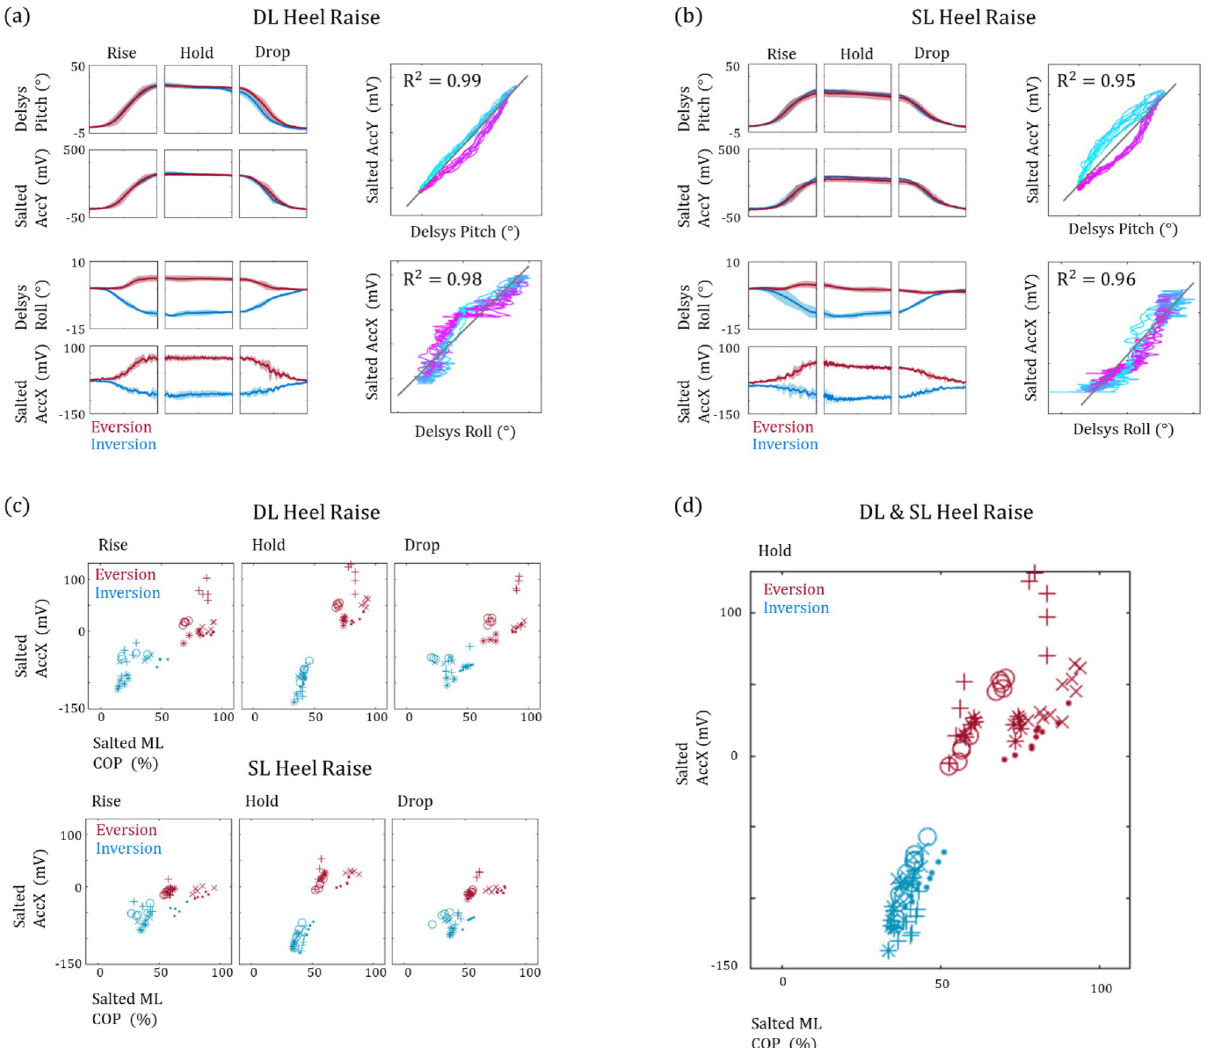
Figure 4. Analysis of acceleration data obtained from Salted smart insoles during heel raise. A representative plot of foot pitch and roll obtained from Delsys Trigno sensors and acceleration data from the smart insoles during ( a ) double leg and ( b ) single leg heel raise is shown. The far-right panels show their linear relationship, and the black lines represent the estimated regression line. ( c ) A distinctive separation between heel raises performed with ankle eversion and inversion from all five subjects is clearly observable on the two-dimensional plane. Both the mean roll and MPP were acquired via the smart insoles. ( d ) Data from the two ankle orientations are separable even when double and single leg conditions are not